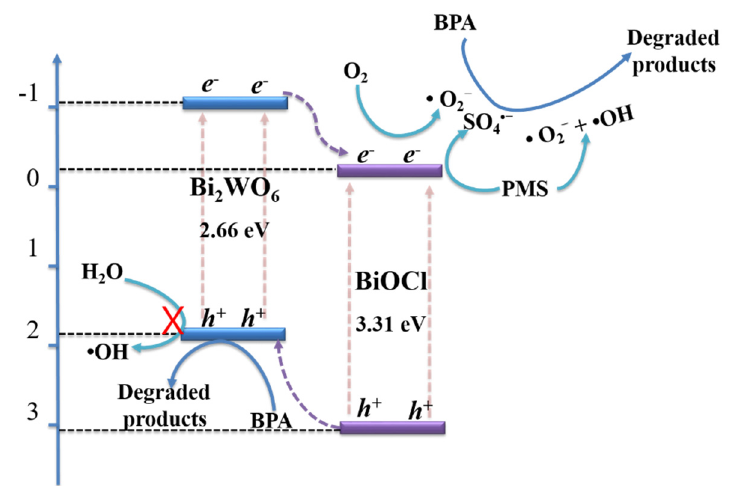
Figure 15. A proposed mechanism for BPA degradation via Bi 2 WO 6 /BiOCl nanocomposites with PMS